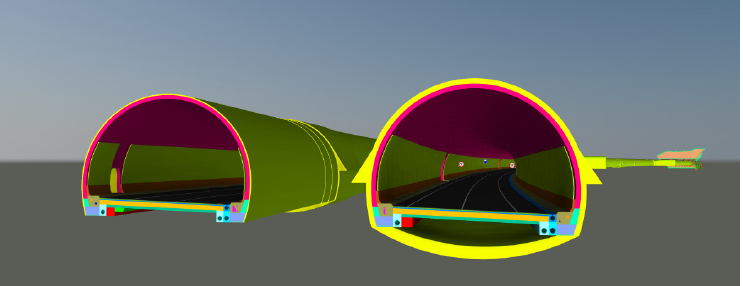
Figure 6. Initial model in Arnotegi tunnel.